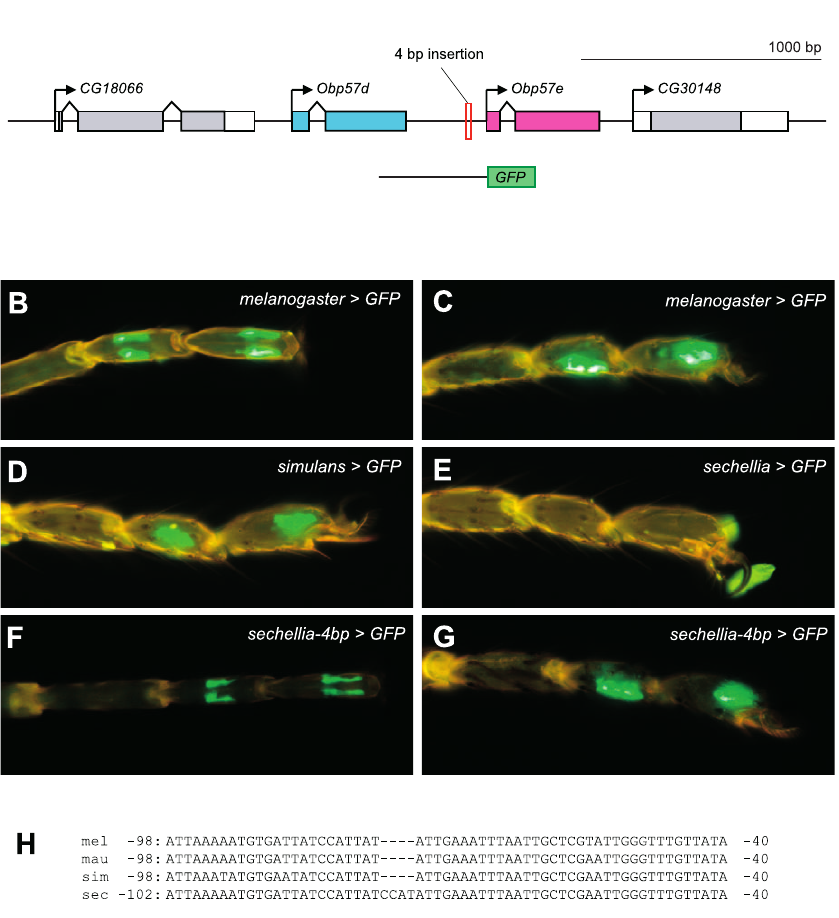
Figure 3. GFP Reporter Assay of Obp57e (A) Genomic structure around the Obp57e gene. Positions of the region used for the GFP reporter construct and 4-bp insertion in D. sechellia are indicated. Arrows on Obp57d and Obp57e indicate the position of the predicted translation-start sites (ATG), not that of the transcription start sites, which are unknown for these genes. (B–G) GFP reporter expression in tarsi. GFP driven by D. melanogaster Obp57e upstream sequence. (B) Dorsal view and (C) lateral view. GFP driven by (D) D. simulans and (E) D. sechellia Obp57e upstream sequence. (F and G) Removal of CCAT insertion from the sechellia . GFP construct restored GFP expression. (F) Dorsal view and (G) lateral view. (H) D. sechellia -specific 4-bp insertion in the upstream regions of Obp57e . Sequences from D. melanogaster (mel), D. simulans (sim), D. mauritiana (mau), and D. sechellia (sec) are aligned. Numbers indicate positions relative to the translation start site